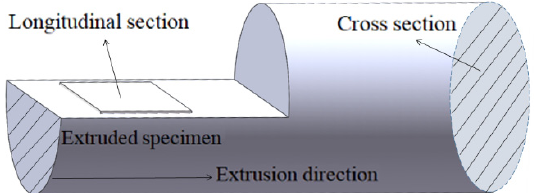
Figure 1. The dimensions of tensile specimens used in this study (unit: mm).